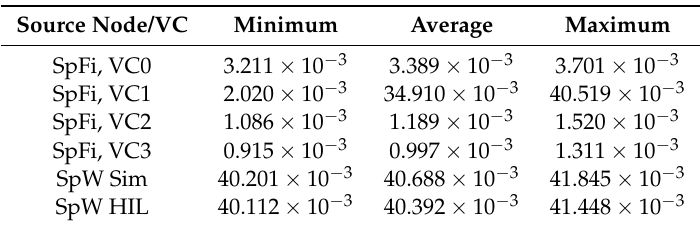
Table 4. Packet latency for each source node to the sink